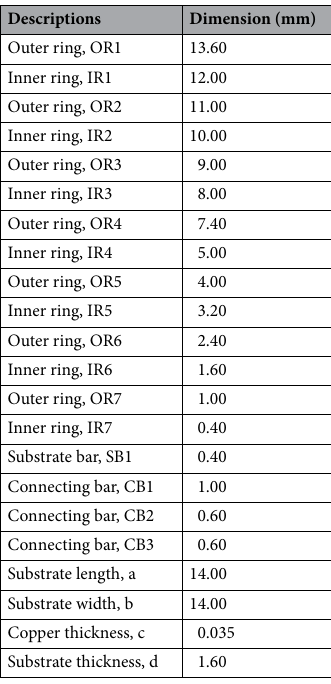
Table 1. Dimension details of the proposed SM